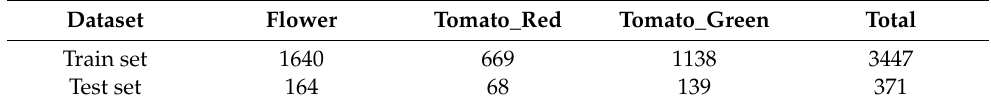
Table 1. The number of targets for each category. Figure 3. Images in the dataset used for object detection model training and testing: ( a ) tomato flower; ( b ) unripe tomatoes ; ( c ) unripe tomatoes.